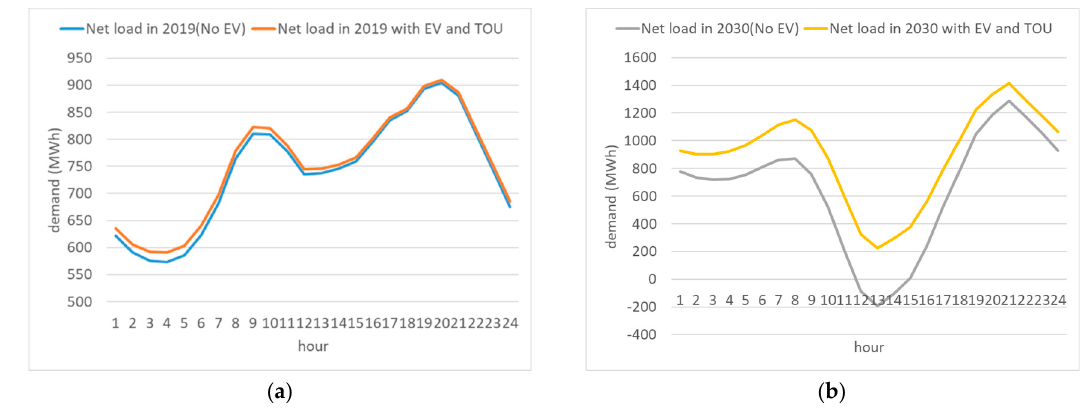
Figure 7. Net load changes with EV demand affected by a TOU program in 2019 and 2030: ( a ) 2019; ( b ) 2030.